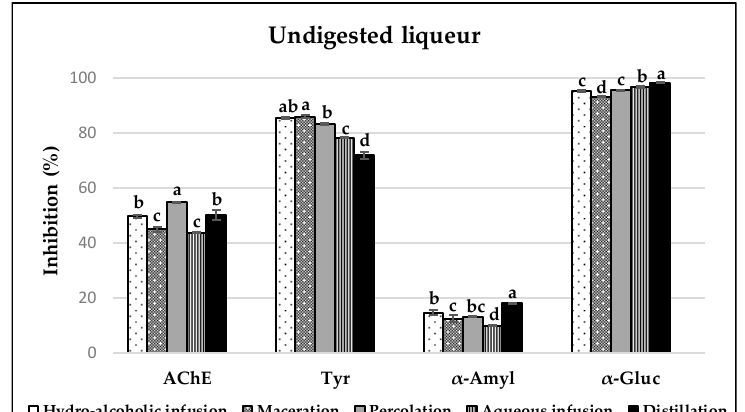
Figure 4. Enzyme [acetylcholinesterase (AchE), tyrosinase (tyr), α -amylase ( α -amyl) and α -glucosidase ( α -gluc)] inhibitory capacities of undigested carob liqueurs obtained with different extraction methods. For each enzyme (AchE, tyr, α -amyl, or α -gluc) inhibition method, values marked with different letters indicate a significant difference ( p < 0.05).